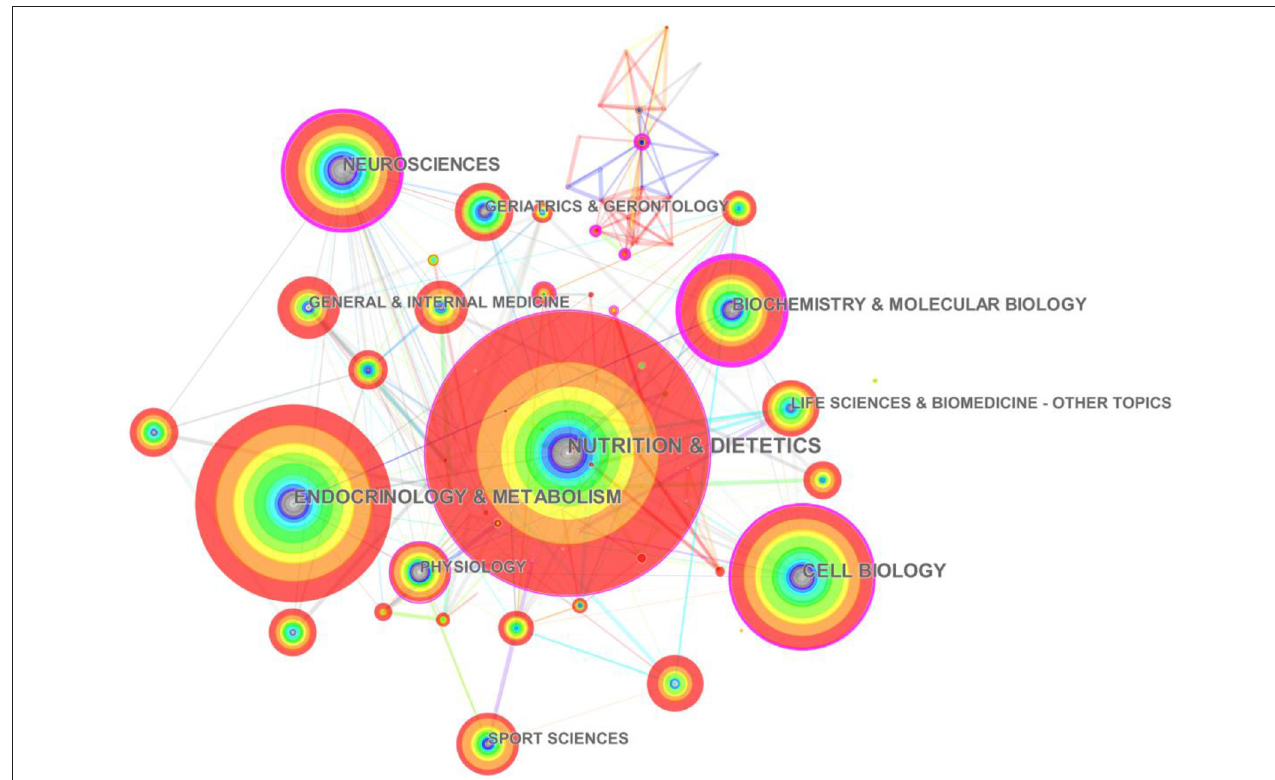
FIGURE 5 | Knowledge mapping of disciplines related to intermittent fasting research.